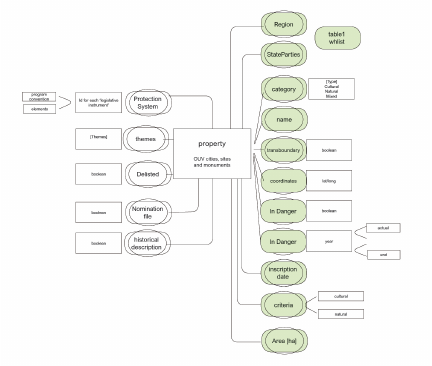
Figure3 Scheme of WH list data model.